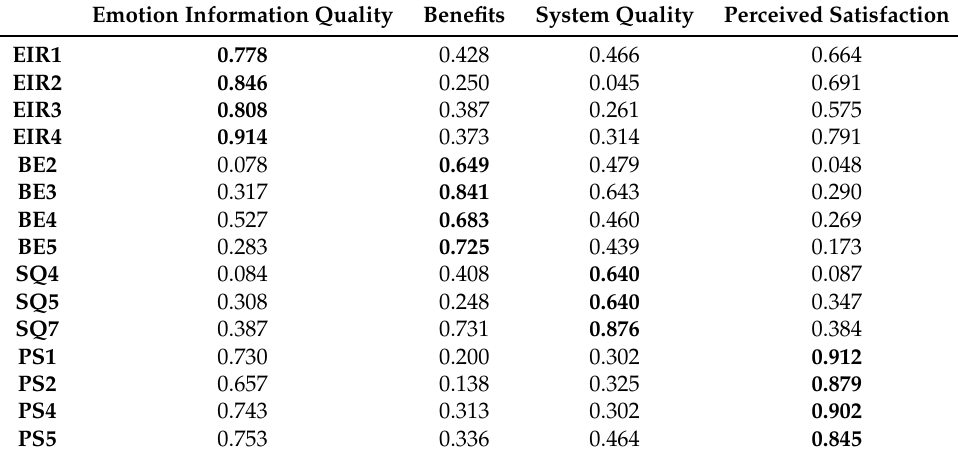
Table 3. Cross loadings for indicators.